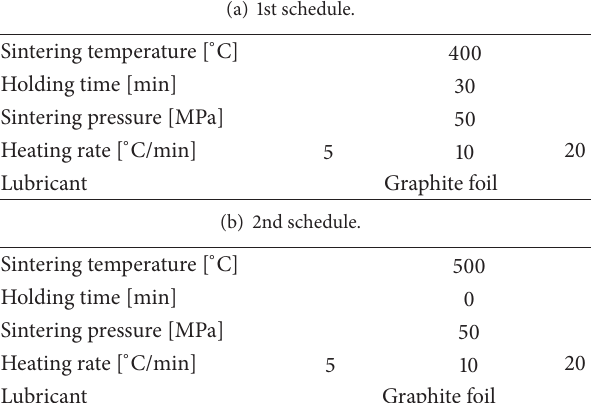
Table 2: Experimental schedules for hot pressing of Al-Mg alloy